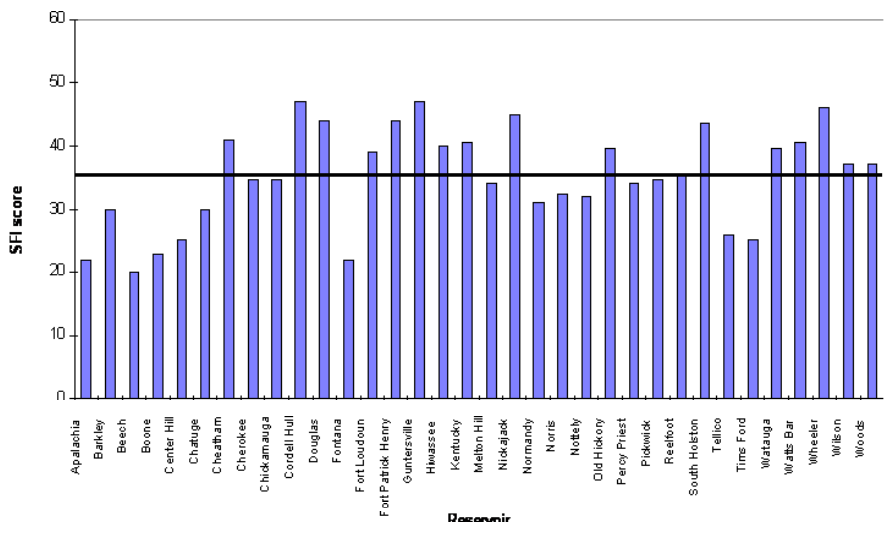
FIGURE 3. Black bass SFI scores for 2000. Line indicates overall average